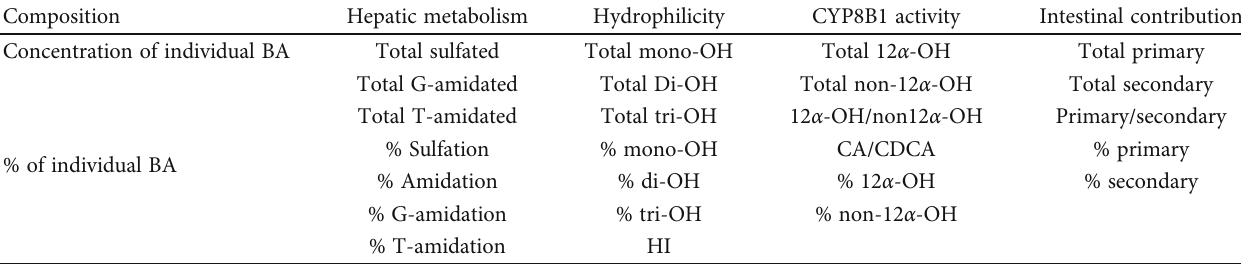
Table 1: List of BA